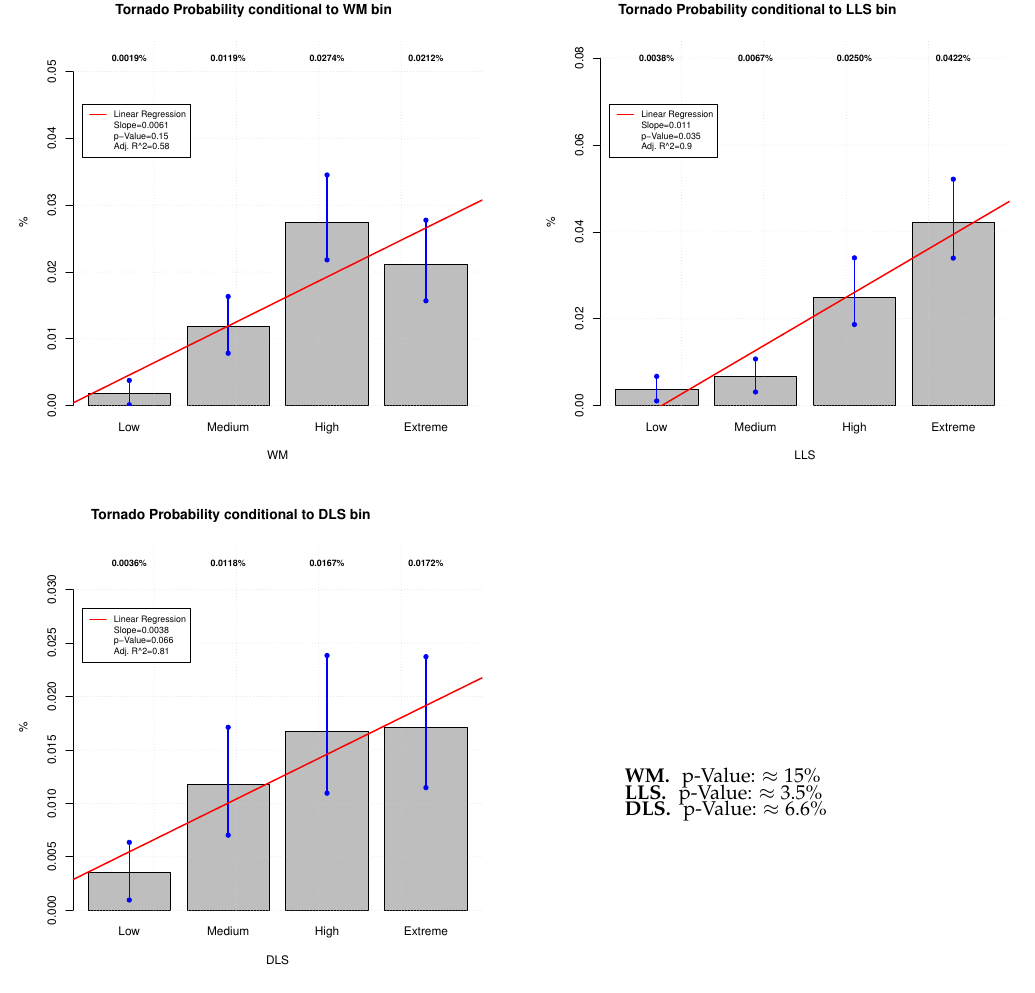
Figure A4. Same as Figure 5 but considering the ERA-Interim